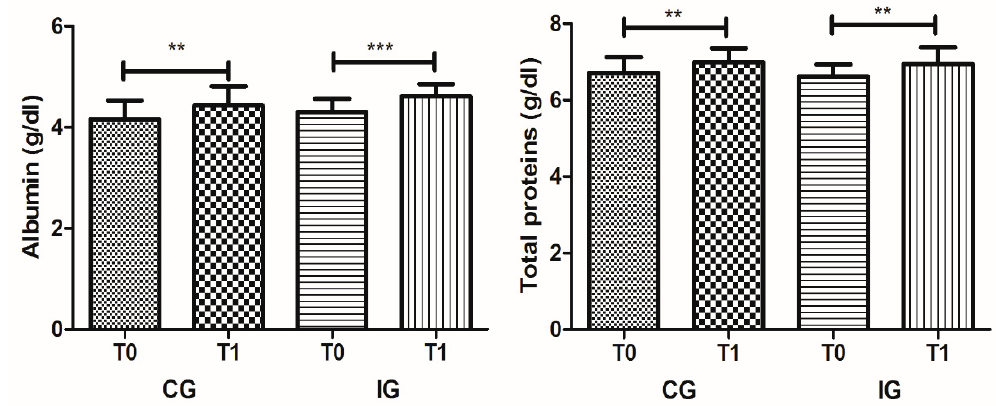
Figure 1. Albumin and total protein serum levels in the control group (CG) and intervention group (IG) at T0 and T1 moments (** p < 0.01; *** p < 0.001).